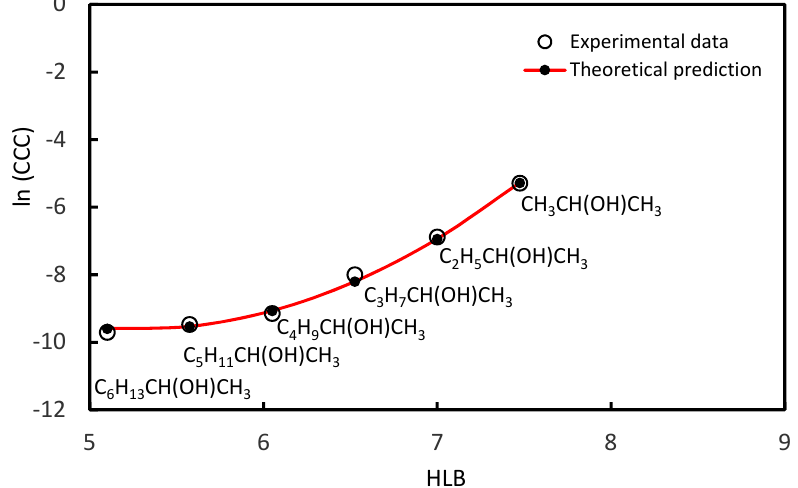
Figure 3. Experimental [37] and theoretical (see Equation (2)) values of ln(CCC) versus HLB values of homologue series of secondary alcohols CH 3 CH(OH)CH 3 –C 6 H 13 CH(OH)CH 3